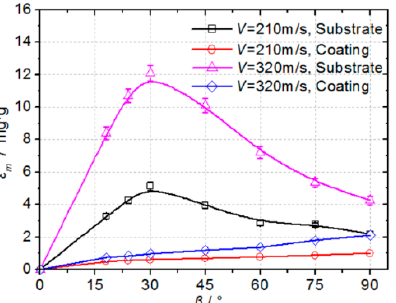
Figure 9. The variation of erosion rate with β for the boronized coating and substrate material (D 32